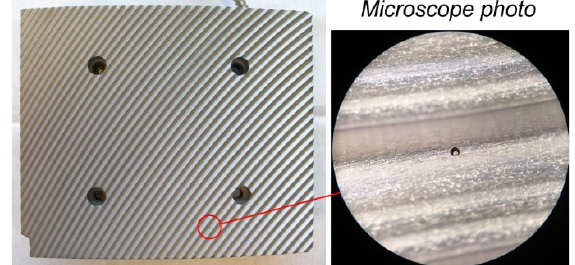
Fig. 8. Schematic visualisation of model temperature zones around and inside a thermocouple. Left: The entire tile with total heat capacity C B and exposed surface area A tl . Cylindrical zones around the thermocouple, which expand into the depth: near bulk A NB (grey) and intermediate bulk f IB A tl (fraction of A tl dark green). Right: side view of the thermocouple cross section [6]. Absorbing surface area A SM with heat capacity C SM . The metal-metal joint with the heat capacity C M is the position of the temperature measurement T M and it is located several 10 µm below the surface [6]. The heat flux has to cross insulating material with model heat conductances k SM and k MN